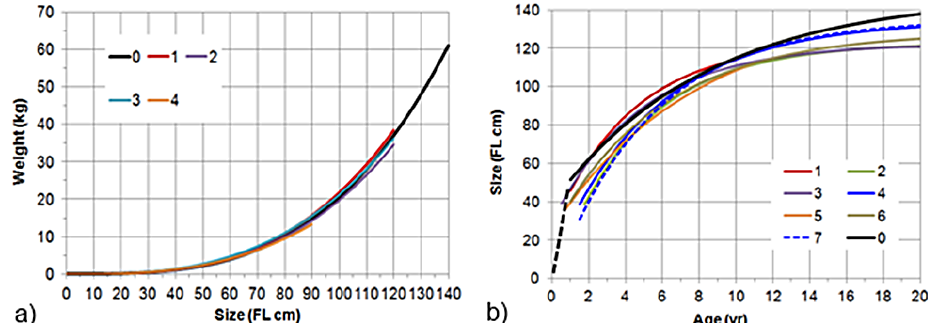
Figure 5. Left: South Pacific size-at-age (top) and weight-at-length (bottom) relationships used in SEAPODYM simulation (black curve) compared to other functions proposed in the literature. Right: population structure (average 1971–2000) in % tonnes resulting from the optimization with SEAPODYM and the NCEP-ORCA2-PISCES environmental forcing. References for weight at size: (0) this study (Hoyle and Davies (2009) for South Pacific albacore), (1) Santiago (1993) for North Atlantic albacore, (2) Penney (1994) for South Atlantic albacore, (3) Chen et al. (2010) for North Pacific albacore, and (4) Megalofonou (1990) for Mediterranean albacore. References for size at age: (0) this study (adapted from MULTIFAN estimate in Santiago and Arrizabalaga (2005), (1) Bard (1981), (2) ICCAT (1996), (3) Santiago and Arrizabalaga (2005), (4) Bard (1973), (5) Gonzales-Garces (1983), (6) Fernandez (1992), and (7) Yang